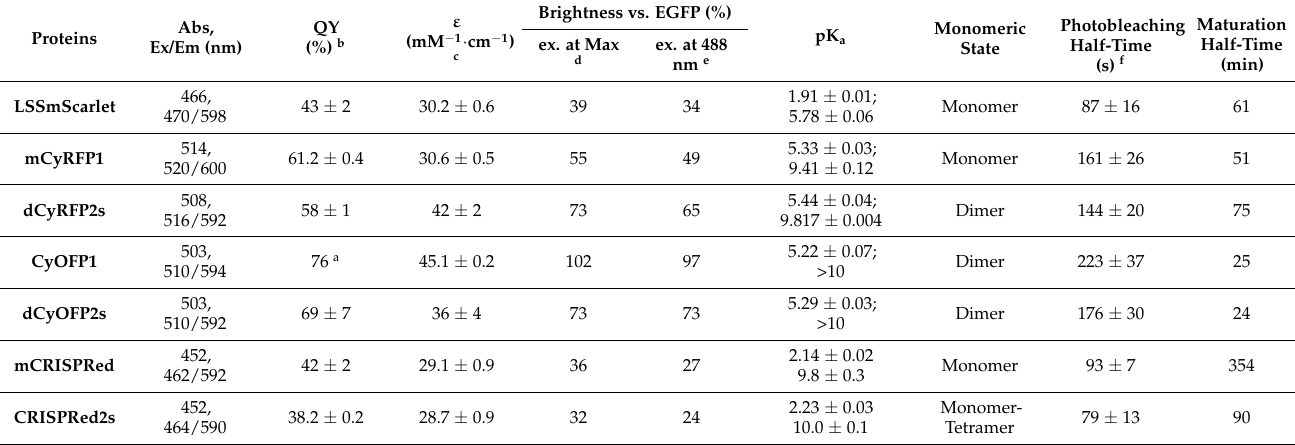
Table 1. In vitro properties of the LSSRFPs. a Data from [3]. b QY was determined at pH 7.40. CyOFP1 (QY = 0.76 [3]) was used as the reference standard. c Extinction coefficients were determined by alkaline denaturation. d Molecular brightness was calculated as a product of the quantum yield and extinction coefficient at maximal absorption and normalized to the brightness of EGFP that has an extinction coefficient of 56,000 M − 1 · cm − 1 and quantum yield of 0.6 [2]. e Brightness corrected for the decreased absorption at 488 nm. f Half-time to bleach until 50%. One-photon photobleaching was performed under metal halide lamp on droplets of protein solution (45 µ M final protein concentration) in oil. Under identical conditions, mEGFP had photobleaching half-time of 305 ± 38 s. Standard deviations are